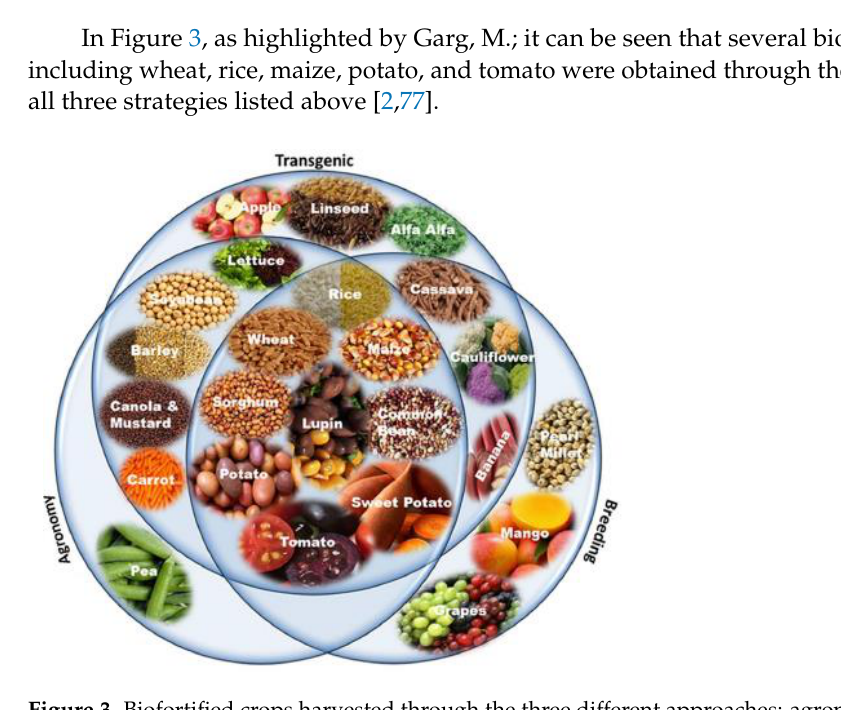
Figure 3. Biofortified crops harvested through the three different approaches: agronomic; traditional breeding; transgenic [2].